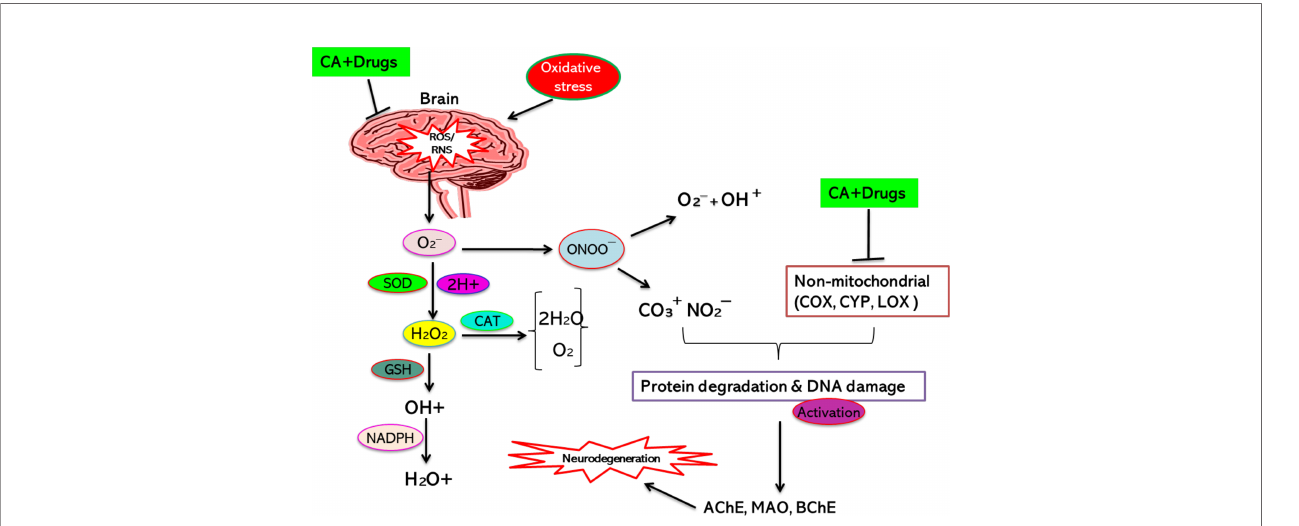
FIGURE 2 | CA ’ s synergistic action with other agents/drugs (neuroprotective) for inhibiting neurodegeneration. [Adapted from Maity et al. (228)]. This fi gure was drown by